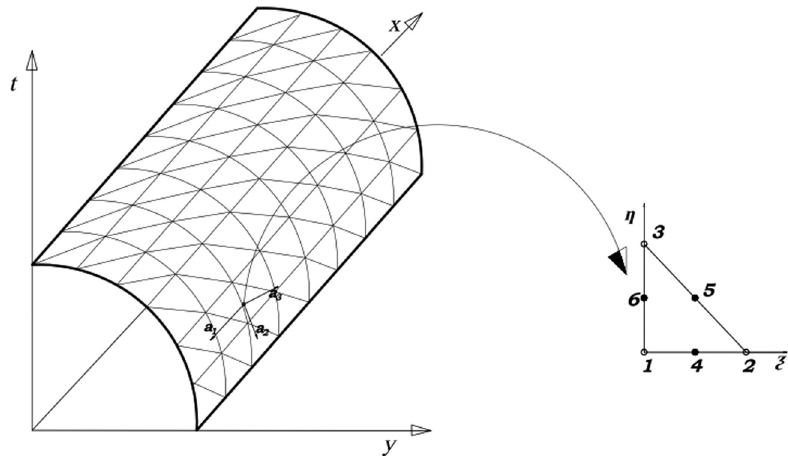
Figure 1: Triangular shell